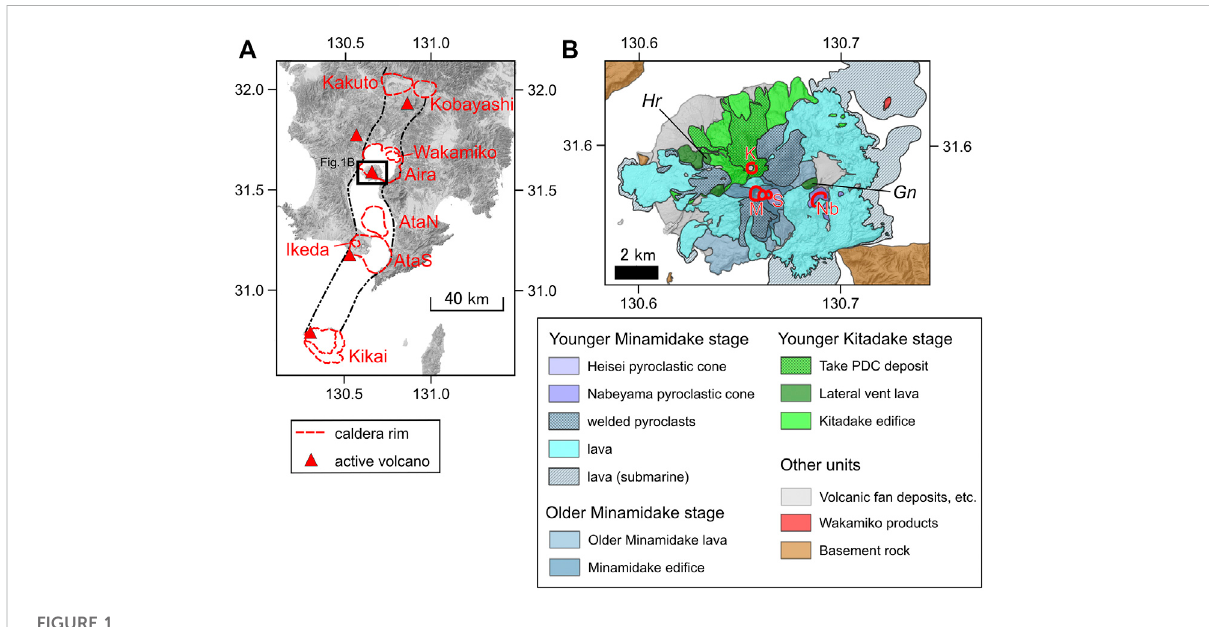
FIGURE 1 (A) Distribution of active volcanoes (red triangles) de fi ned by Japan Meteorological Agency, and calderas (broken red lines) younger than ~0.6 Myr, in southern Kyushu. The topographic rims of each caldera are de fi ned after Machida et al. (2001), Kobayashi et al. (2013), and Tatsumi et al. (2018). The dashed-and-dotted lines along the north-south direction represent “ Kagoshima graben ” (Tsuyuki, 1969). Two smaller calderas (Wakamiko and Ikeda caldera) nest within larger calderas (Aira and AtaS calderas, respectively). The GSI Maps (Shaded Map and Slope Map; https://maps.gsi.go.jp/development/ichiran.html) published by Geospatial Information Authority of Japan are used as the background maps. (B) Geological map of Sakurajima volcano (modi fi ed from Kobayashi et al., 2013). Red lines represent crater rims described in Kobayashi et al.